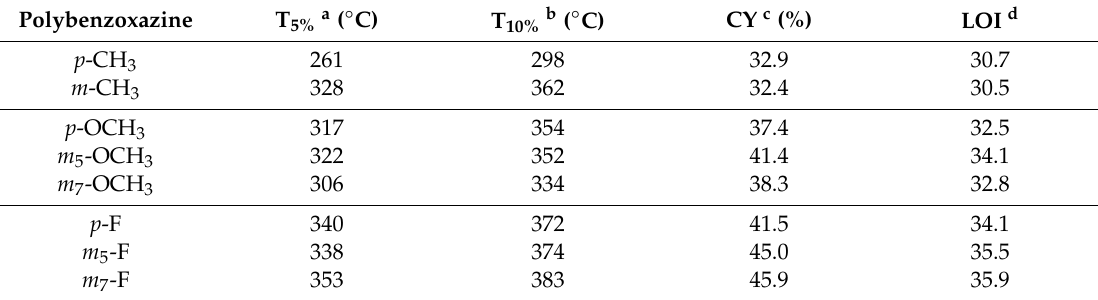
Table 2. Thermogravimetric analysis (TGA) of polybenzoxazines obtained from thermal treatment of substituted